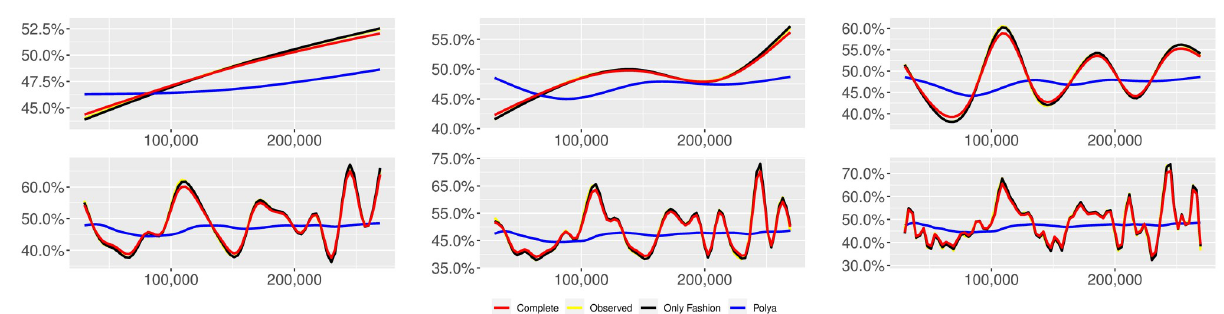
PLOS ONE | https://doi.org/10.1371/journal.pone.0249634 April 15, 2021 22 /